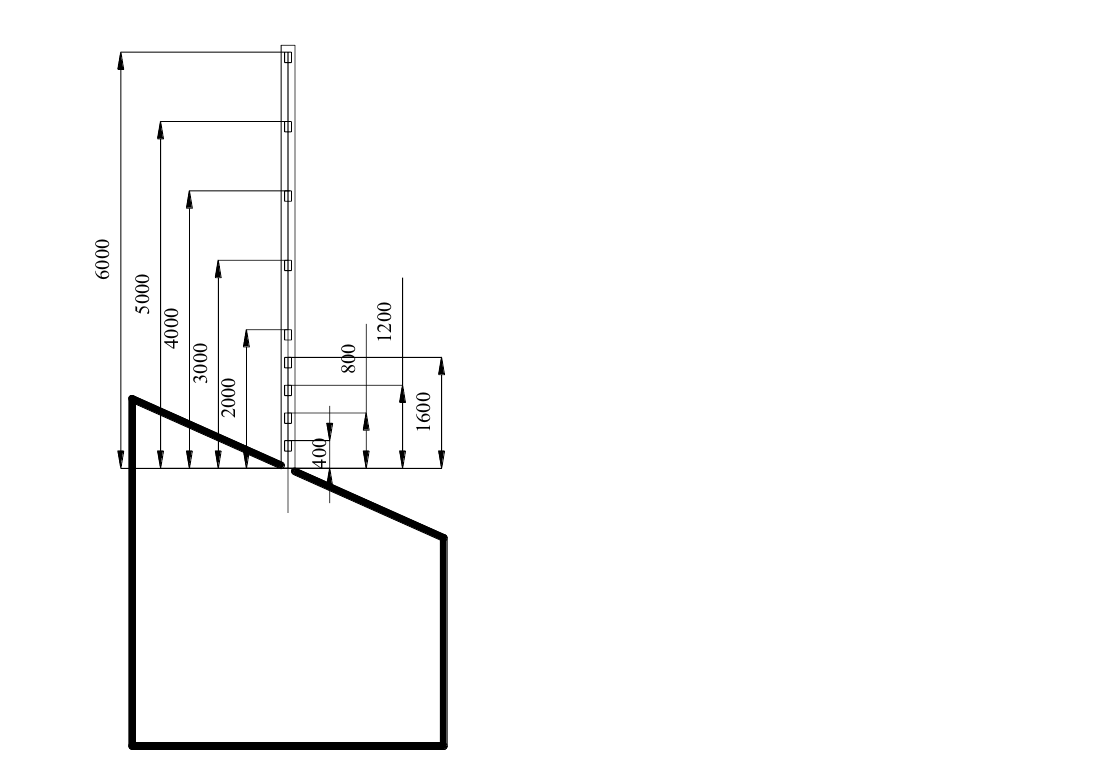
Figure 30. Layout of roadway roof separation monitoring points